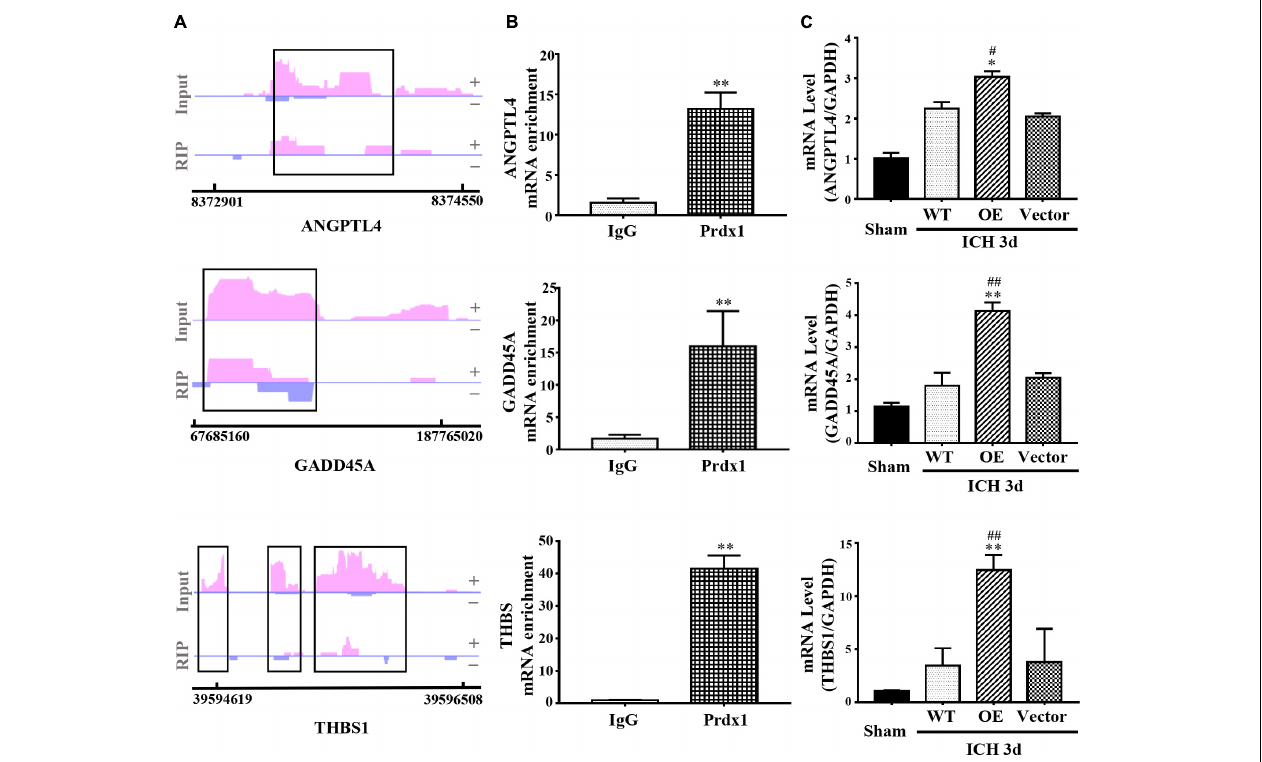
FIGURE 7 | Prdx1 plays similar roles in vitro and in vivo . (A) Prdx1 RIP-seq peaks are shown as track signals of ANGPTL4, GADD45A and THBS1. The peak area is indicated by the black frame. (B) RIP-qPCR analysis of Prdx1 binding RNAs in astrocytes with IgG RIP as a negative RIP control (ANGPTL4: F = 4.297, t = –13.551, ∗∗ P < 0.01 versus IgG, n = 3; GADD45A: F = 12.277, t = –8.909, ∗∗ P < 0.01 versus IgG, n = 3; THBS: F = 4.072, t = –20.619, ∗∗ P < 0.01 versus IgG, n = 3). (C) qRT-PCR was performed in four groups of ANGPTL4, GADD45A, and THBS1 mRNA (ANGPTL4: F = 87.049, df = 3, ∗ P < 0.05 versus Vector, # P < 0.05 versus WT, n = 3; GADD45A: F = 73.252, df = 3, ∗∗ P < 0.01 versus Vector, ## P < 0.01 versus WT, n = 3; THBS: F = 20.553, df = 3, ∗∗ P < 0.01 versus Vector, ## P < 0.01 versus WT, n =